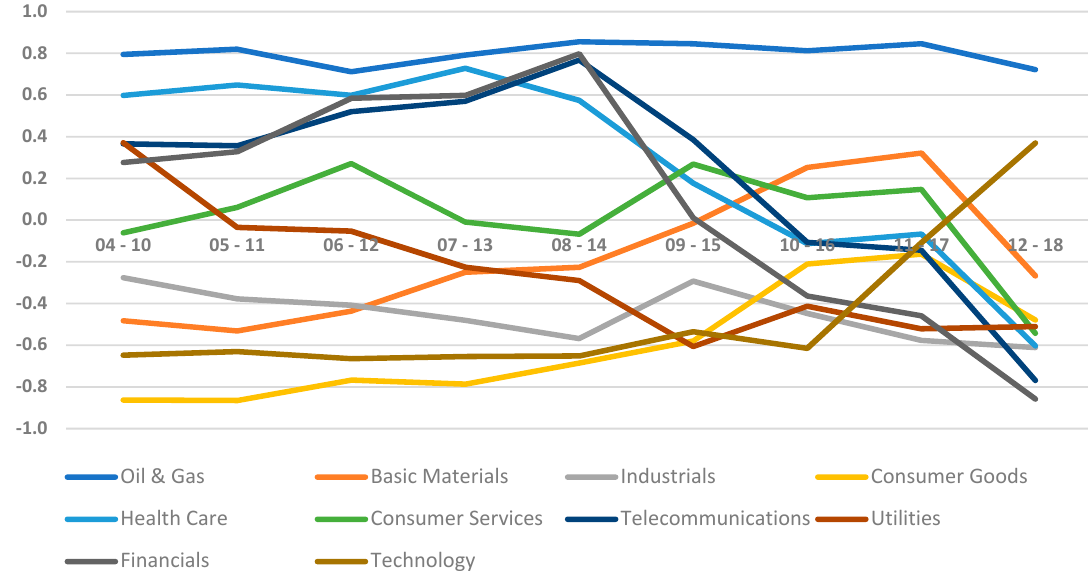
Figure 3. Rolling estimates of correlations.